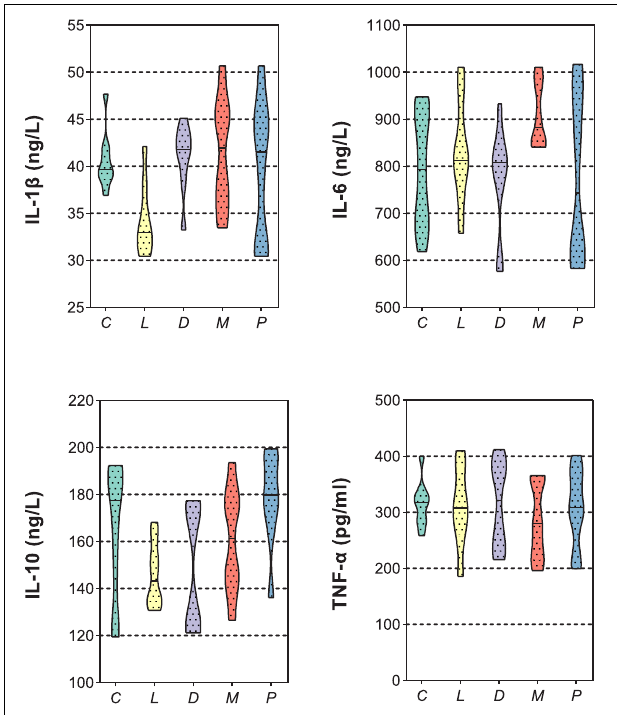
FIGURE 2 | Effects of different diets on the blood immune index in weaned piglets. IL-1 β , interleukin 1 β ; IL-6, interleukin 6; IL-10, interleukin 10; TNF- α , tumor necrosis factor α